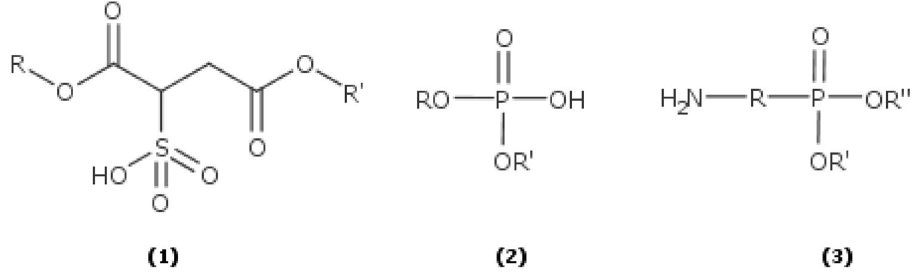
Fig. 9 Generic structures of some naphthenate